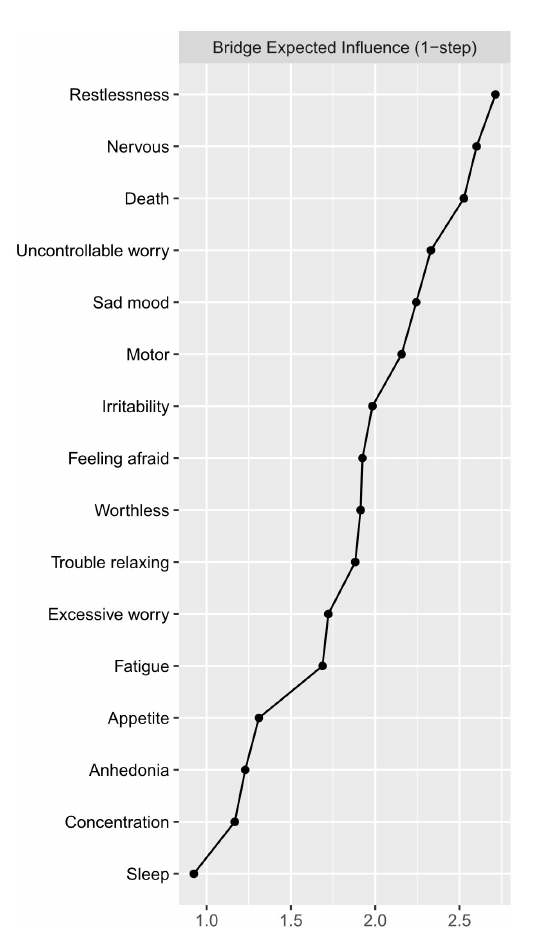
FIGURE3 The bridge expected influence plot. The X-rays represented the bridge expected influence of each node. Nodes with higher bridge expected influence are recognized as bridge symptoms that drove the comorbid depression and anxiety